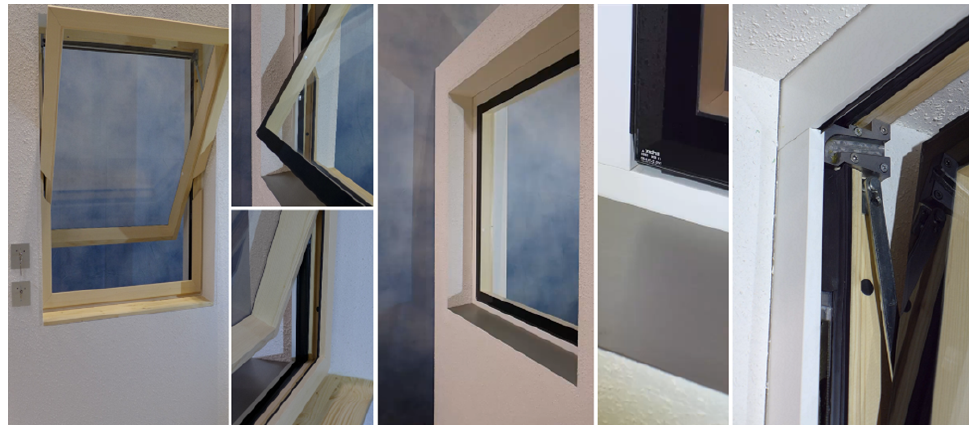
Figure 9. Window prototype K. Different photographs of the prototype illustrating appearance in closed and open states as well as